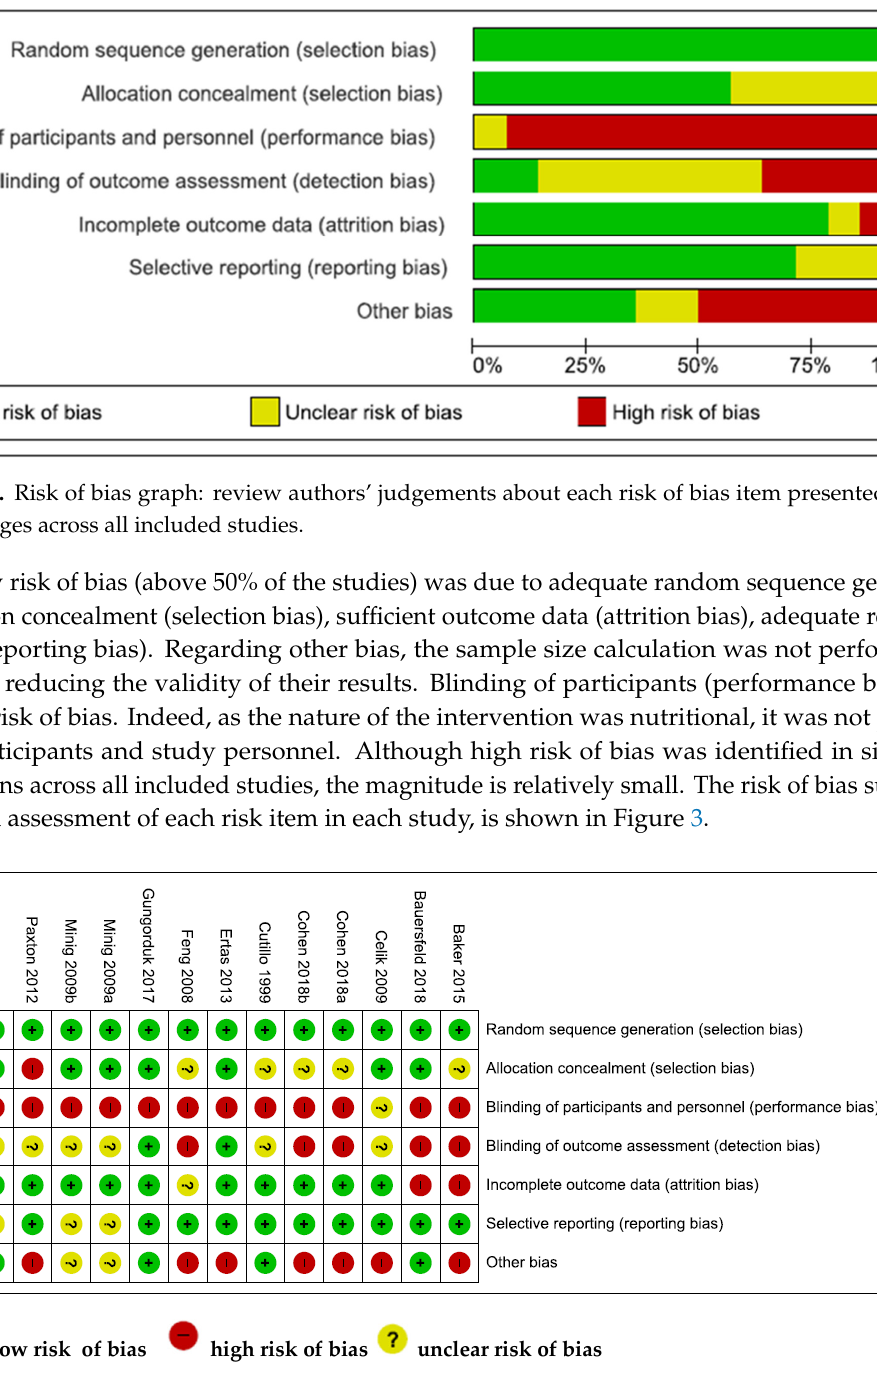
Figure 3. Risk of bias summary: review authors’ judgments about each risk of bias item for each included study.